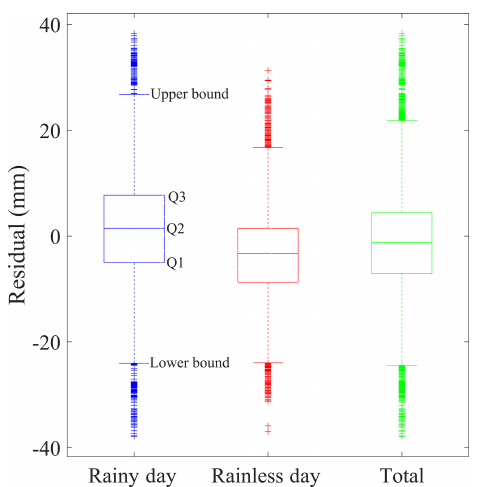
Figure 8. Box plots of the SWV residuals (differences between the tomography-computed SWV and the GAMIT-estimated SWV) for the KYC1